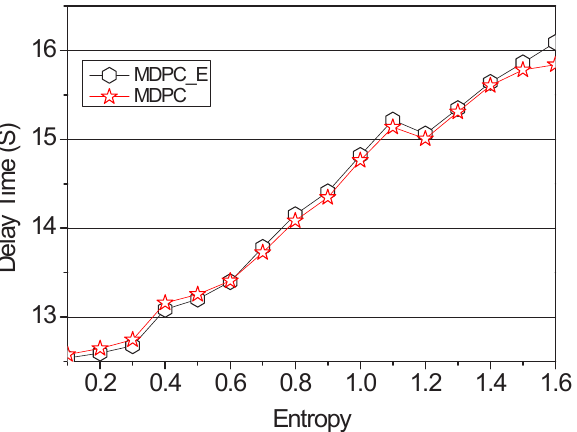
Figure 11. Delay time applying the entropy according to the value of the entropy (0.1–1.6). Figure 12 shows a graph of the delay time measured with the entropy value from 0.1 to 0.5. When the entropy value is 0.5 or less, the accuracy of the probability is 90% or more, so that the possibility of the vehicle visiting the RSU with the lowest probability is reduced. MDPC was not caching content to the lowest-probability RSU but cached the highest-probability RSU with a weight. Therefore, when the vehicle visits the RSU with the highest probability, the RSU reduces the content size received from the adjacent RSU via the backhaul link, thereby reducing the backhaul traffic.